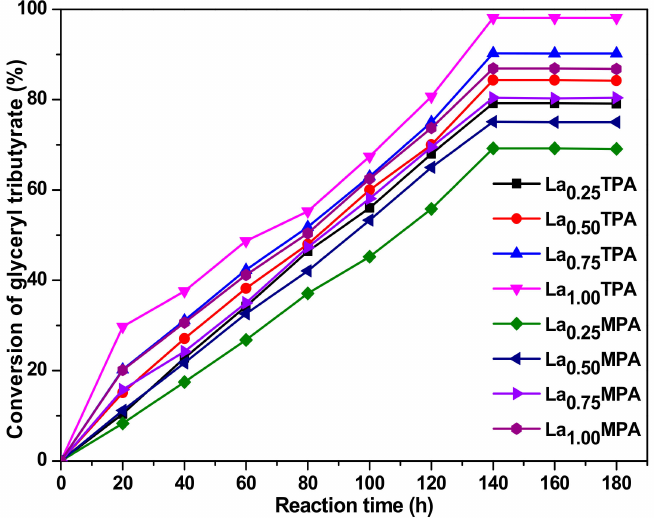
Figure 7. Influence of the reaction time on the conversion of glyceryl tributyrate over La x TPA and La x MPA